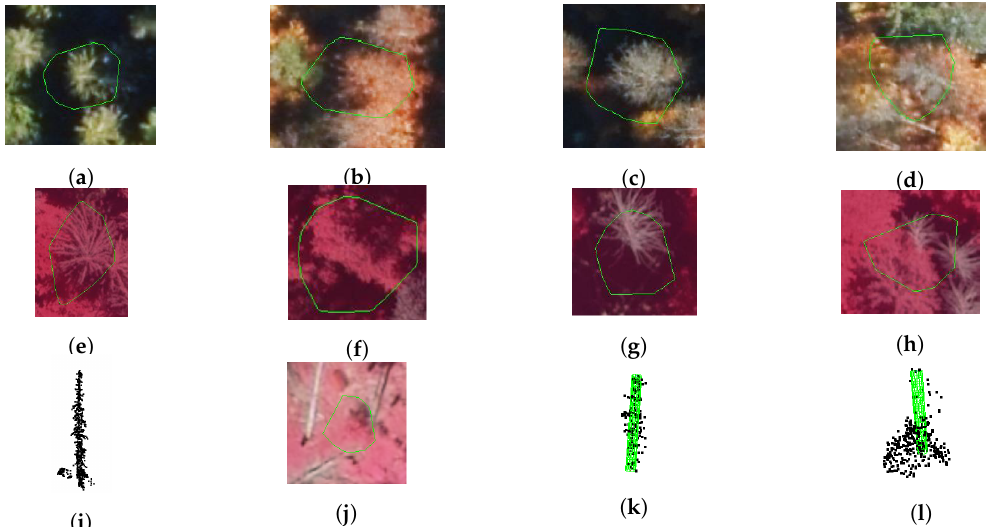
Figure 3. Subfigures ( a ) to ( d ): Examples for living spruce, broadleaf tree, dead spruce, and difficult case in National Park Šumava. ( a ) Living spruce. ( b ) Broadleaf tree. ( c ) Difficult example for a broadleaf tree in fall. Leaf-off. ( d ) Difficult example for a broadleaf tree. Partly leaf-off. Subfigures ( e ) to ( h ): Examples for living spruce, broadleaf tree, dead spruce, and difficult case in Bavarian Forest National Park.